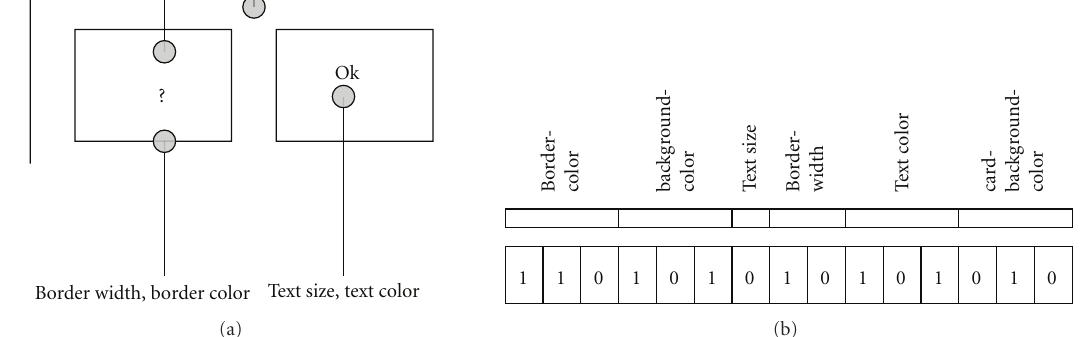
Figure 3: User interface property encoding in a 15-bit string.